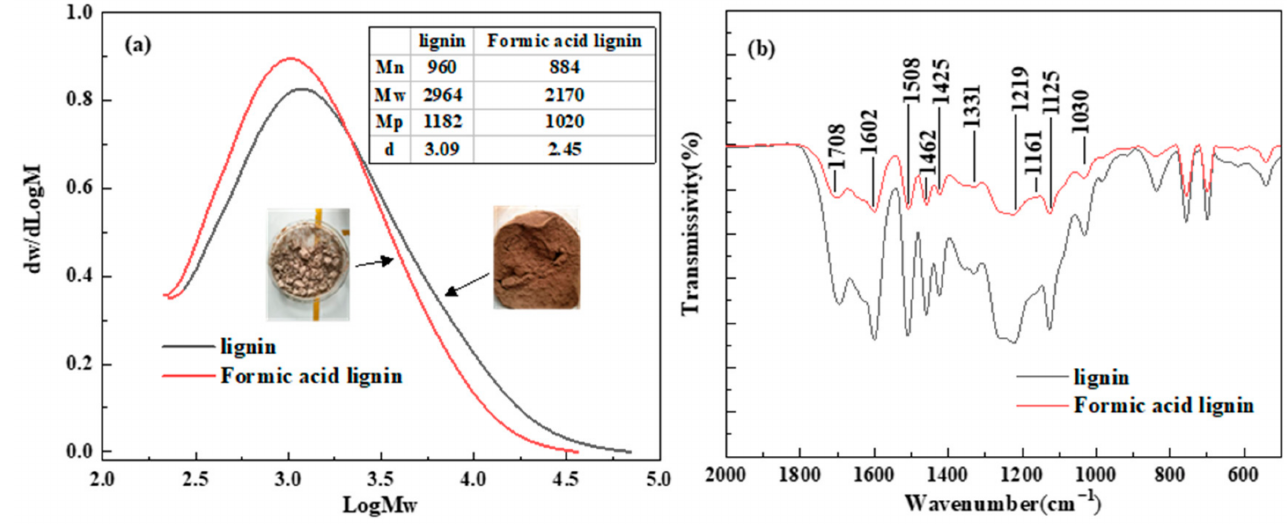
Figure 4. Infrared spectra of lignin and formic acid lignin with molecular weight distributions. ( a ) GPC; ( b )